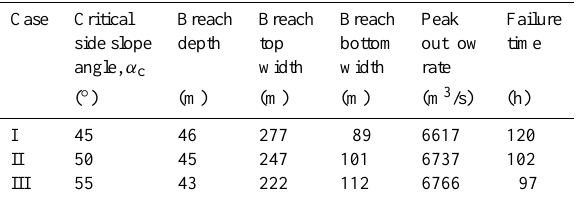
Table 5. Sensitivity of key breaching parameters to the critical side- slope angle in the Tangjiashan Landslide Dam